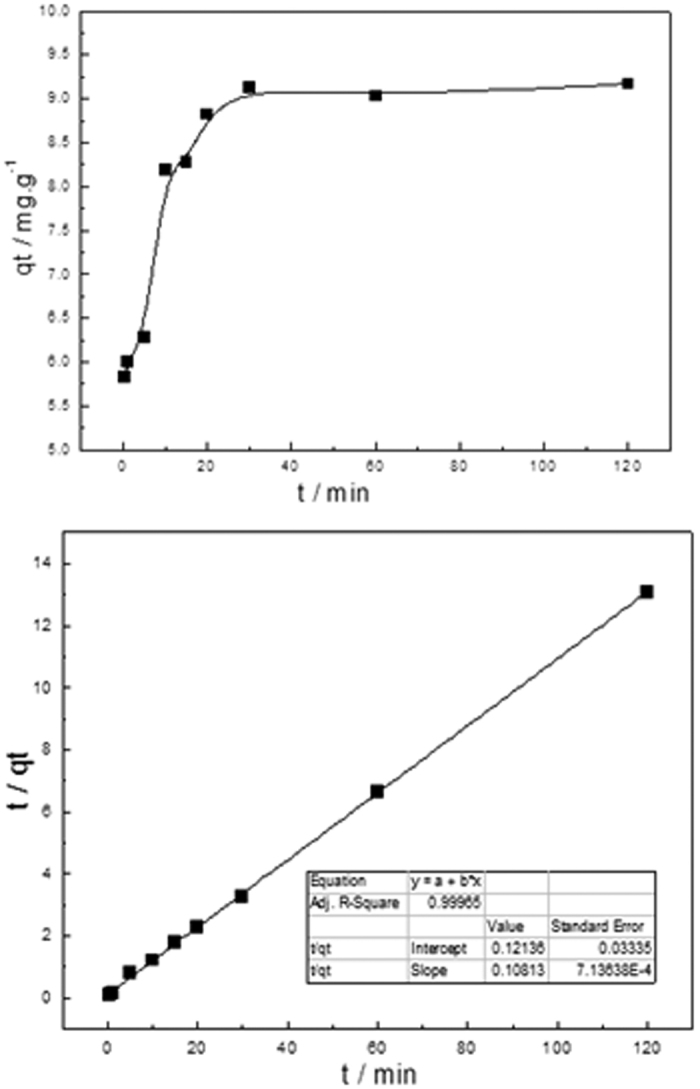
(a) Effects of the mixing time on the phosphate adsorption capacities (a) and the pseudo second order kinetic equation fitting line of phosphate adsorption. (b) Where k2 (gmg−1min−1) is the pseudo second order rate constant. (Fe3O4@NH2-MIL-101(Fe), 12 mg; NaH2PO4 c0 = 0.6 mgL−1; V = 0.2 L; T = 293 K).